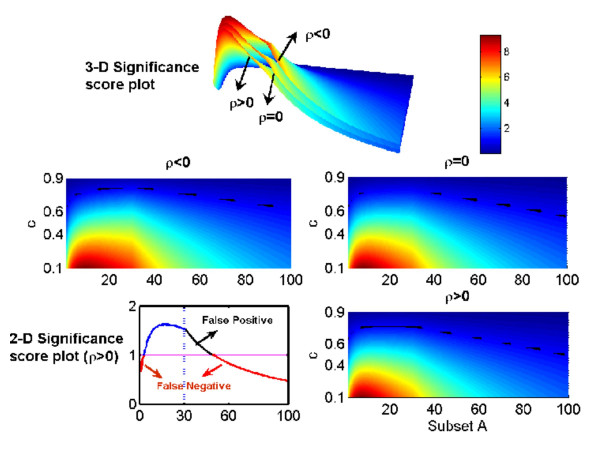
Significance score vs. c and subset A = {1, 2, ..., i}, i = 1, 2, ..., m. Upper panel is the score vs. c and A with different ρ. Middle panel and bottom panel, right, is the projection of it onto two-dimensional space. The thick, broken lines indicate the line where the significance score is one. Bottom panel, left, is a section of c = 0.7. The horizontal line corresponds to a score of one. The discontinuity of the derivative of the significance score is at n = 30, indicated by the vertical, dashed line.